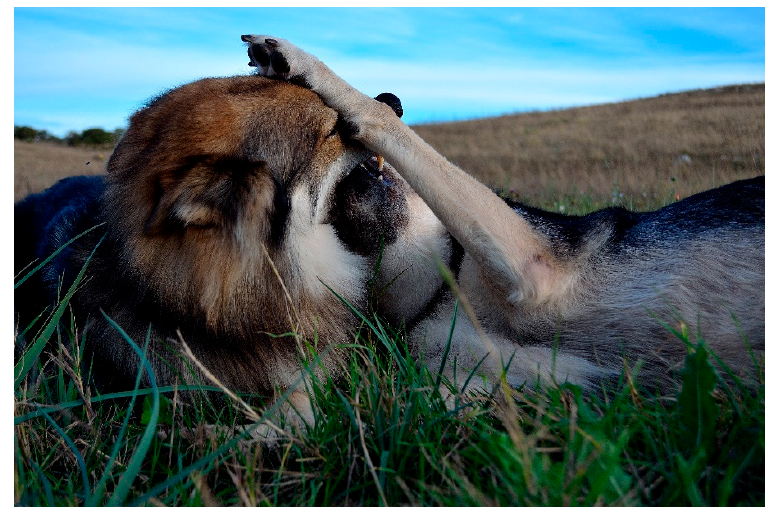
Figure 8. The Czech wolf is doing a muzzle grab during a bout of play.